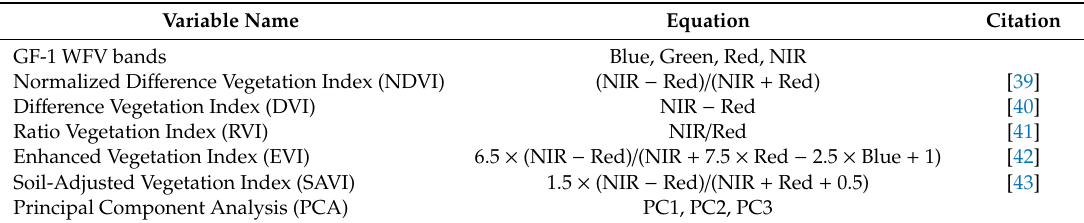
Table 2. Predictor variables derived from GF-1 WFV imagery and used as inputs in the algorithms for detection and mapping of S. alterniflora , including equations and